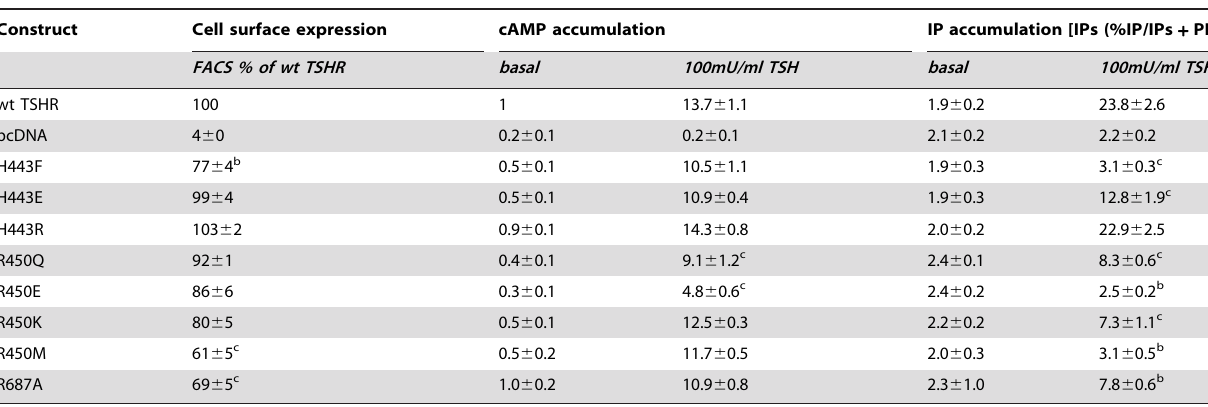
Table 2. Side-chain variations and functional characterization of H443 and R450 in ICL1 and transition to helix 2 and R687 in helix